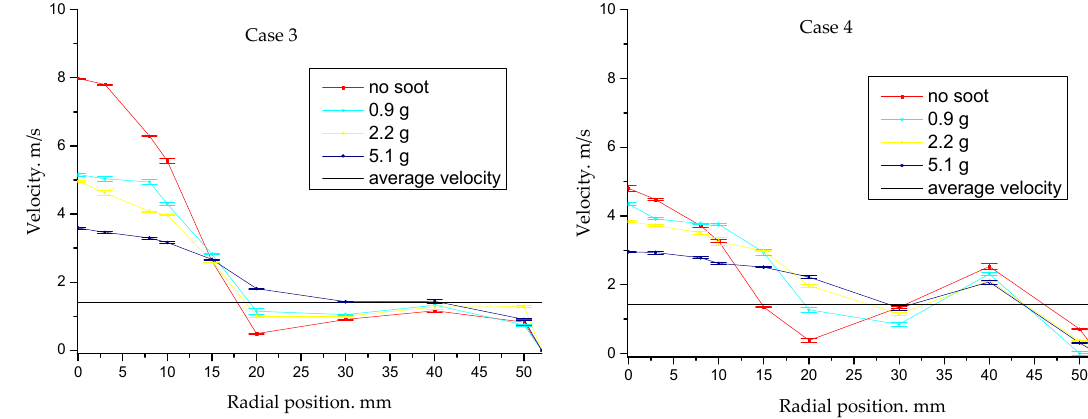
Figure 12. Velocity profiles of case 3 (conventional cone) and case 4 (NURBS cone); the average velocities are 1.41 m/s and 1.64 m/s, respectively.